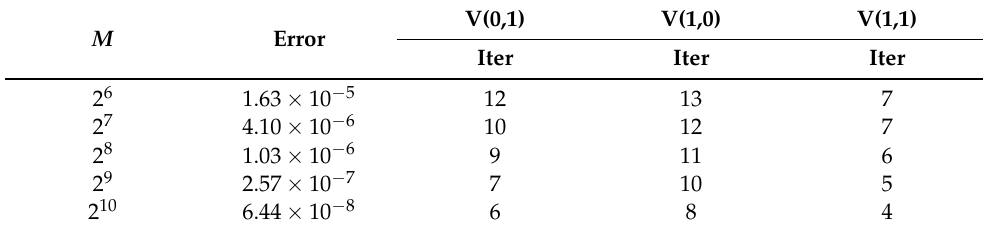
Table 6. L 2 errors for (84) with ω = 0.5 by the second-order